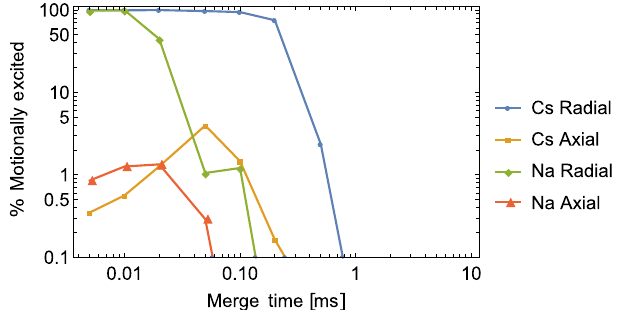
FIG. 5. Minimum merge time. We numerically simulate the motional excitation as a function of merge time with fixed trap